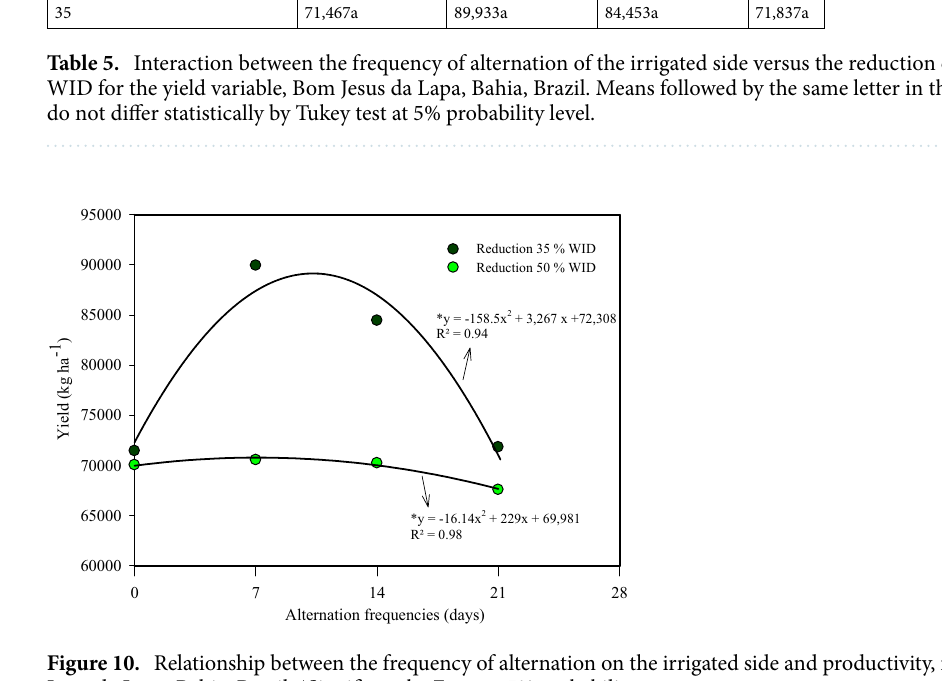
Figure 10. Relationship between the frequency of alternation on the irrigated side and productivity, in Bom Jesus da Lapa, Bahia, Brazil. *Significant by F test at 5%